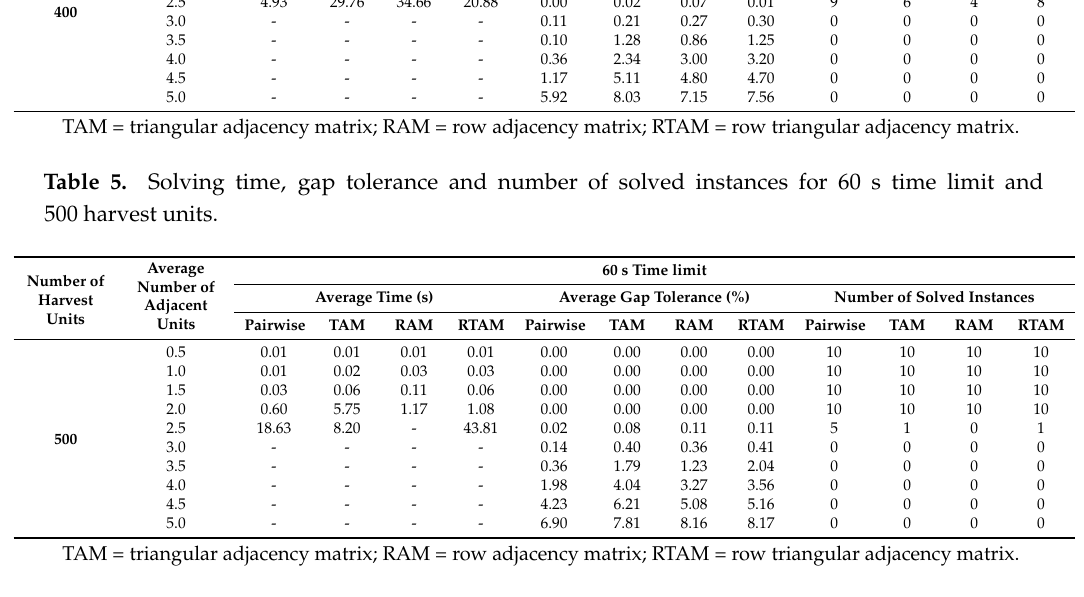
Table 6. Solving time, gap tolerance and number of solved instances for 120 s time limit and 100 harvest units.